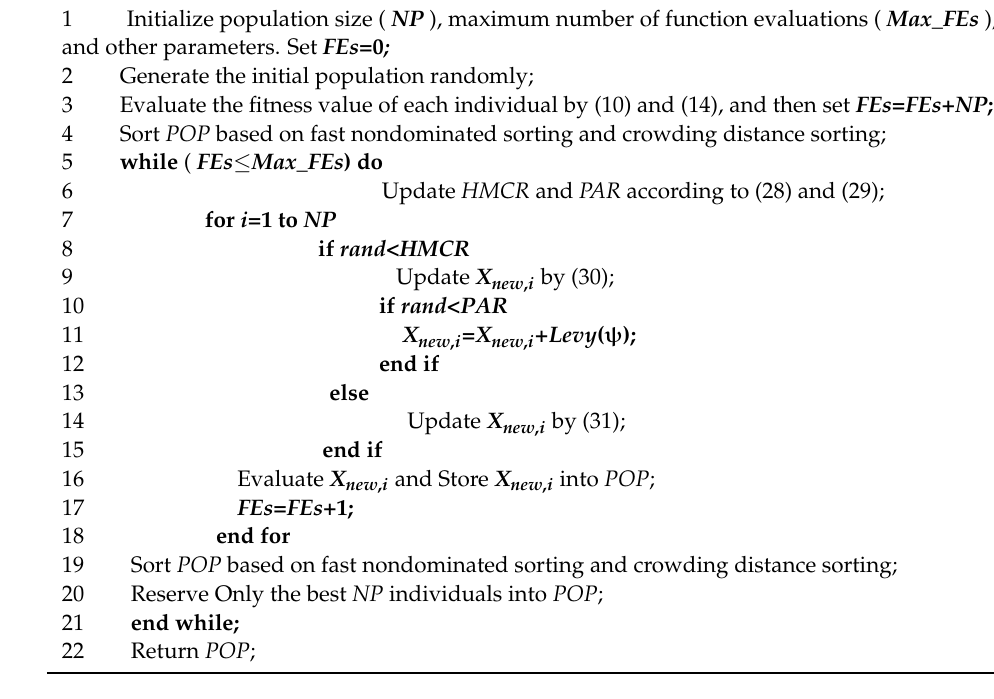
Algorithm 2. The implementation of SAMLHS in solving the DEED IWEv